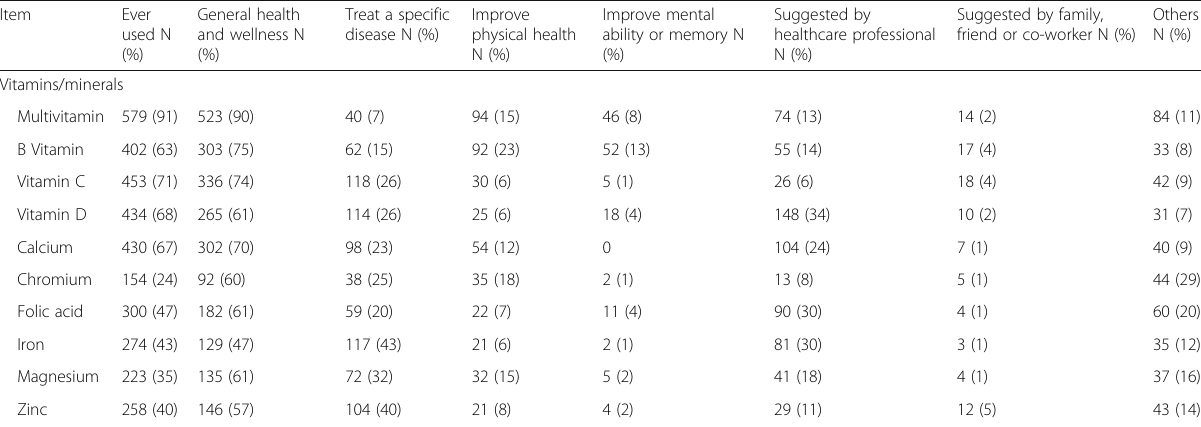
Table 2 Pharmacists ’ self-reported reasons for using vitamins/minerals